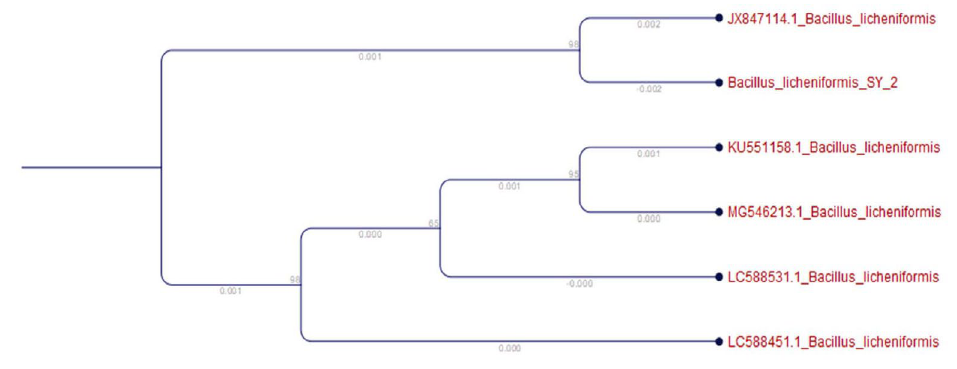
Fig. 6. Alignment of the BLAST query for SY2